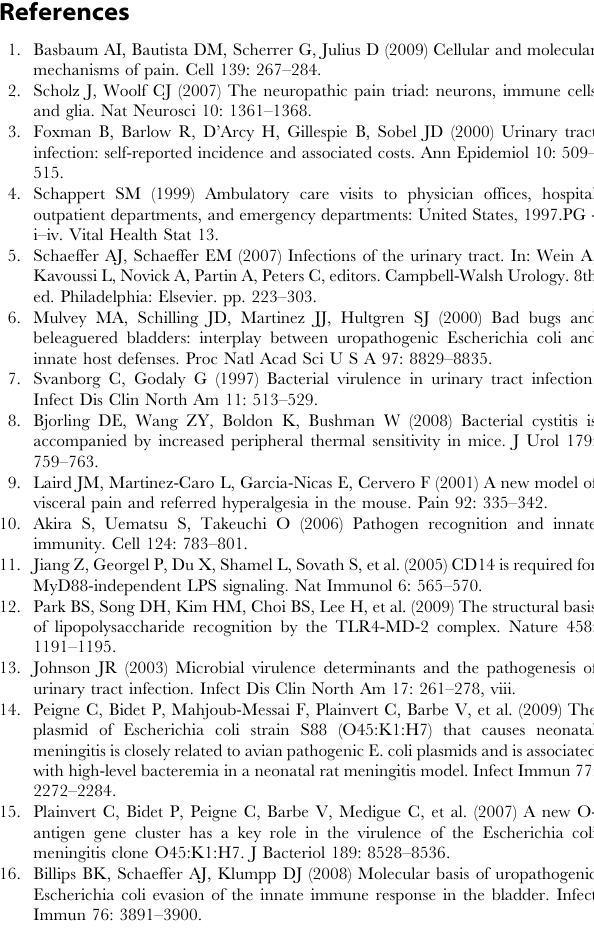
Figure S2 Chronic allodynia from D waaL infection requires TLR4. Mice (n =10) were infected serially with D waaL , and tactile allodynia was quantified in + / + or TLR4 2 / 2 B6 mice. Allodynia following second and third infections was significantly reduced in TLR4 2 / 2 mice relative to + / + mice (P , 0.01). (TIF) Figure S3 O-antigen modulation of 83972-associated pelvic responses. Tactile allodynia of mice infected with 83972 or 83972 D wz with/without a plasmid encoding the wz* cluster of K. pneumoniae in pWQ288 in response to two sequential infections (n= 10). 83972 D wz induced significant allodynia in response to serial infection that was not observed in mice receiving serial infection with 83972 D wz /pWQ288 (P , 0.05). Table S1 Paw sensitivity determined by 50% threshold (*p , 0.05). Tactile allodynia of the hind paw was assessed to determine the specificity of pelvic responses. No significant differences were detected. Table S2 Body mass during infection (*p , 0.05). Body mass was assessed as a marker of overall health. No significant changes were detected. Table S3 D waaL-induced chronic pelvic pain (% in- crease). *p , 0.05 compared to all other groups at PID14. After